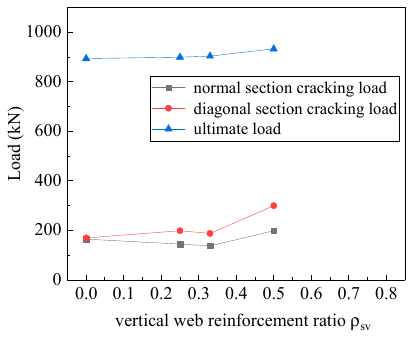
Figure 17. Relation curve between ρ sv and load.